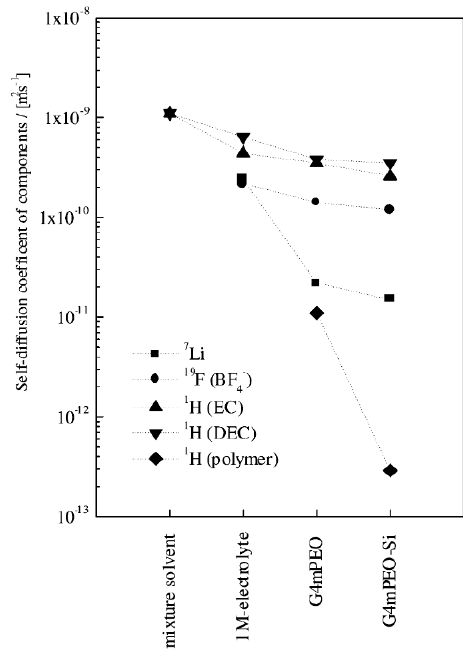
Figure 11. Self-diffusion coefficients of all diffusive components in ethylene carbonate-diethyl carbonate (EC–DEC) (0.27:0.75 mole fraction) mixed solvent, 1 M LiClO 4 EC–DEC liquid electrolyte, swelled G4mPEO membrane and swelled composite G4mPEO–Si membrane (more information on the